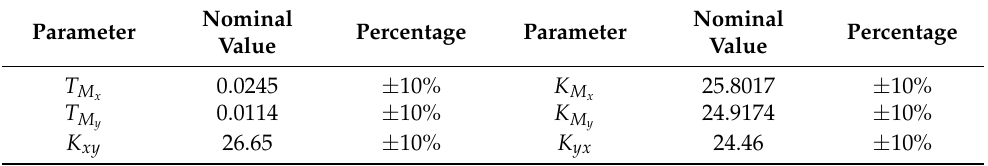
Nominal Percentage Value